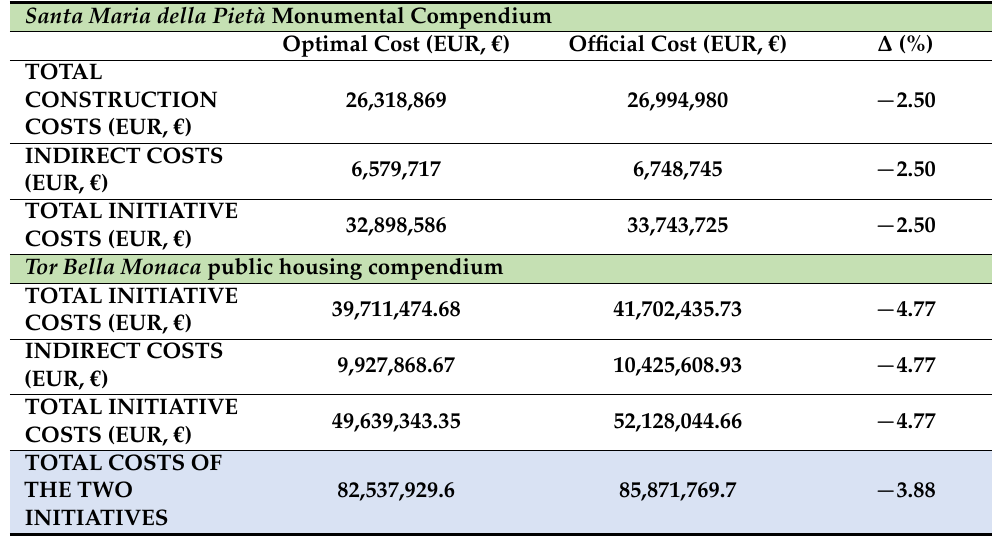
Table 2. Brief framework of the main findings